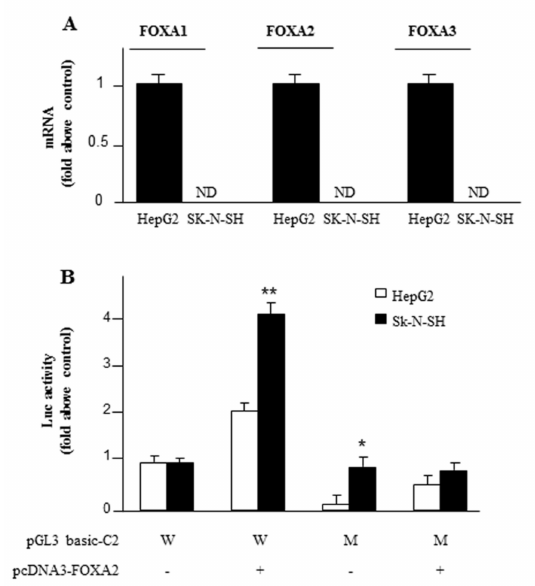
Figure 4. Activation of SLC25A13 gene by FOXA2. ( A ) FOXA1, FOXA2 and FOXA3 mRNA levels in HepG2 and SK-N-SH cells. ( B ) HepG2 and SK-N-SH cells co-transfected with pGL3 basic-LUC vector containing C2 construct (968 / − 19 of the SLC25A13 gene promoter region) wild-type (W) or mutated (M) in FOXA2 binding site and with pcDNA3-FOXA2 ( + : black bars) or empty pcDNA3 (-: white bar) were assayed for LUC activity. Where indicated, di ff erences between samples and relative controls were significant (* p < 0.05 or ** p < 0.01 one-way ANOVA followed by Student’s t